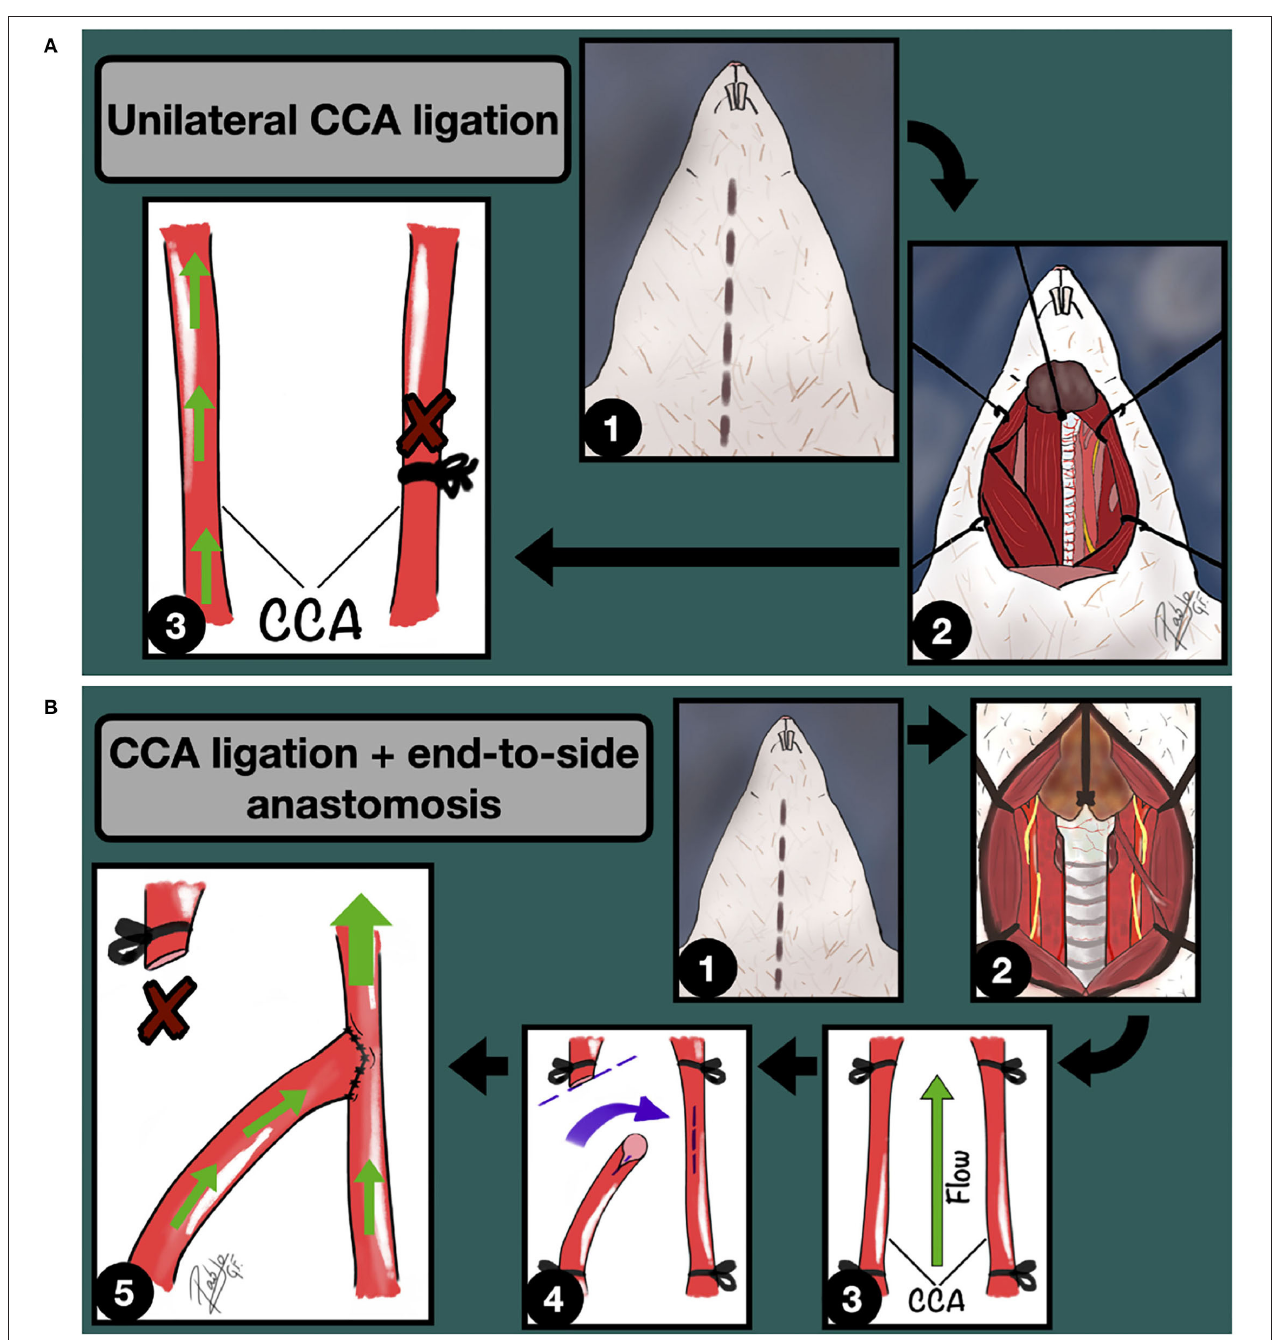
FIGURE 2 | (A) Unilateral CCA ligation model for IA induction through hemodynamic stress increase. 1: Midline cervical incision; 2: Cervical vessels approach and unilateral CCA exposure; 3: Unilateral CCA ligation. The green arrows indicate the blood flow direction. (B) Unilateral CCA ligation + Contralateral End-to-side anastomosis model for IA induction through hemodynamic stress increase. 1: Midline cervical incision; 2: Cervical vessels approach, focusing on the left CCA; 3: CCA clamping; 4: Longitudinal arteriotomy of the parent artery and fish-mouth arteriotomy of the donor vessel; 5: End-to-side anastomosis is completed. The green arrows indicate the blood flow